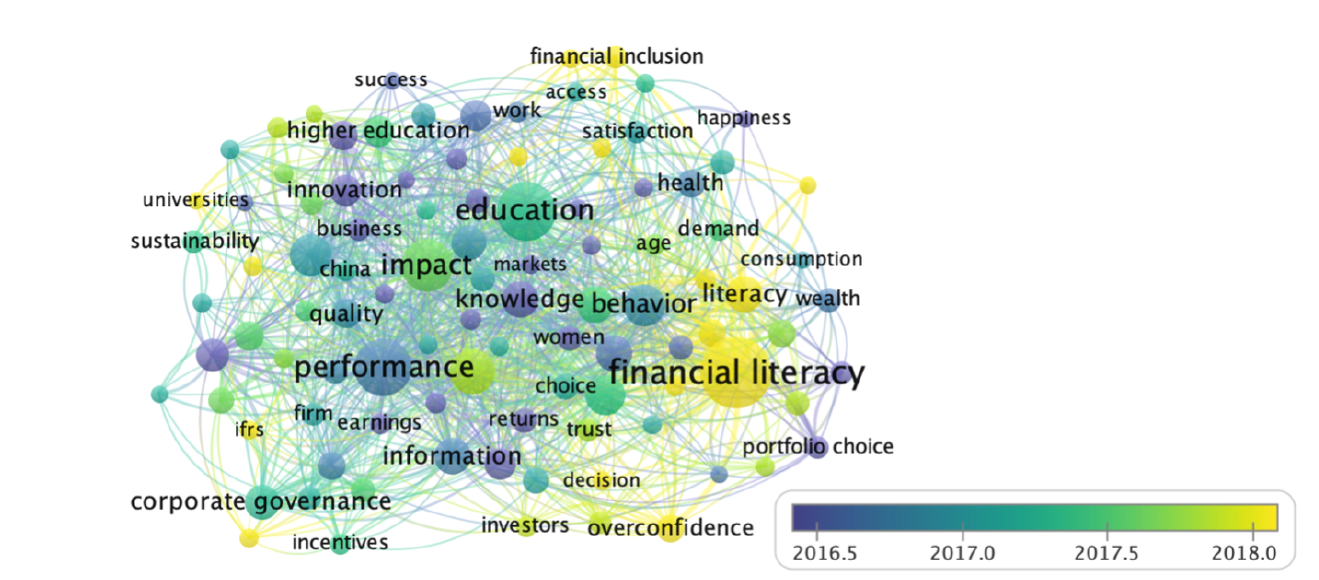
Figure 8. Keywords co-occurrence overlay visualization map according to year (prepared using VOSviewer